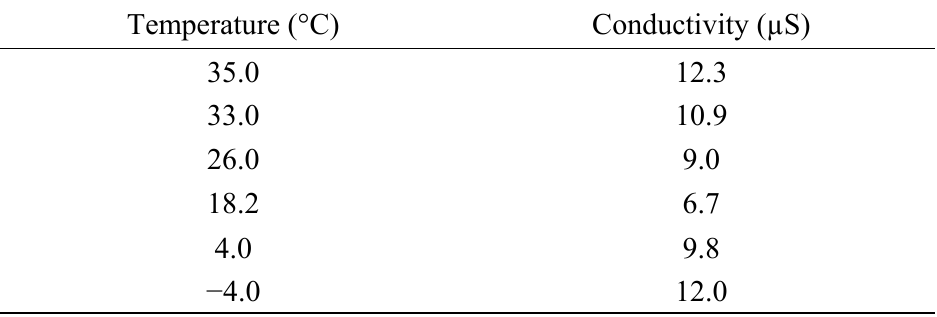
dopant at different 4